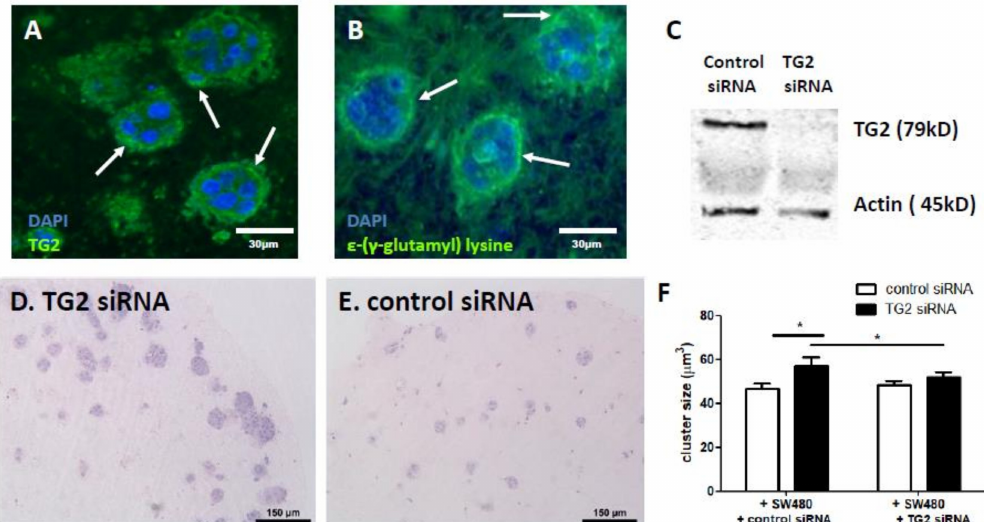
Figure 2. TG2 at the SW480 cluster boundary mediates CRC growth. TG2 is prominently expressed at the invasive edge of SW480 clusters ( A , white arrows indicating CRC / stroma boundary). TG2 activity in the co-cultures was observed by staining for the ε -( γ -glutamyl) lysine isopeptide cross-link ( B ), and prominent at the invasive edge (white arrows indicating CRC / stroma boundary). TG2 siRNA was delivered to fibroblasts ( C ), and co-culture with TG2-silenced fibroblasts resulted in greater cluster growth ( D , E ). Quantification of cluster size indicated that this increase was statistically significant ( F , n = 27). TG2 siRNA delivered to SW480 cells blocked the enhanced cluster size induced by TG2 siRNA delivered to fibroblasts ( F , n = 27). * p <